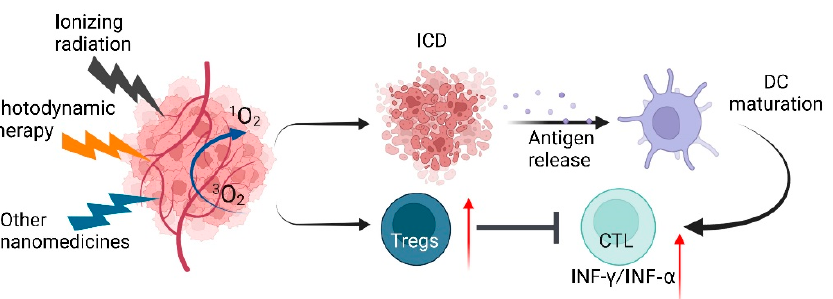
Figure 6. Nanomedicine-induced ICD. Schematic illustration showing that the various nanoparticles (ionizing radiation, photodynamic and other nanomedicines) induce tumor cells to produce a large amount of ROS, thereby inducing ICD and upregulating Tregs. ICD can release many tumor neoantigens, which are phagocytosed by dendritic cells (DCs). DCs mature after cytokine stimulation and present antigens to T lymphocytes. Activated T lymphocytes become effector T cells and are attracted by chemokines, and then migrate to tumors and kill tumor cells. ROS: Reactive oxygen species; ICD: immunogenic cell death; and DCs: dendritic